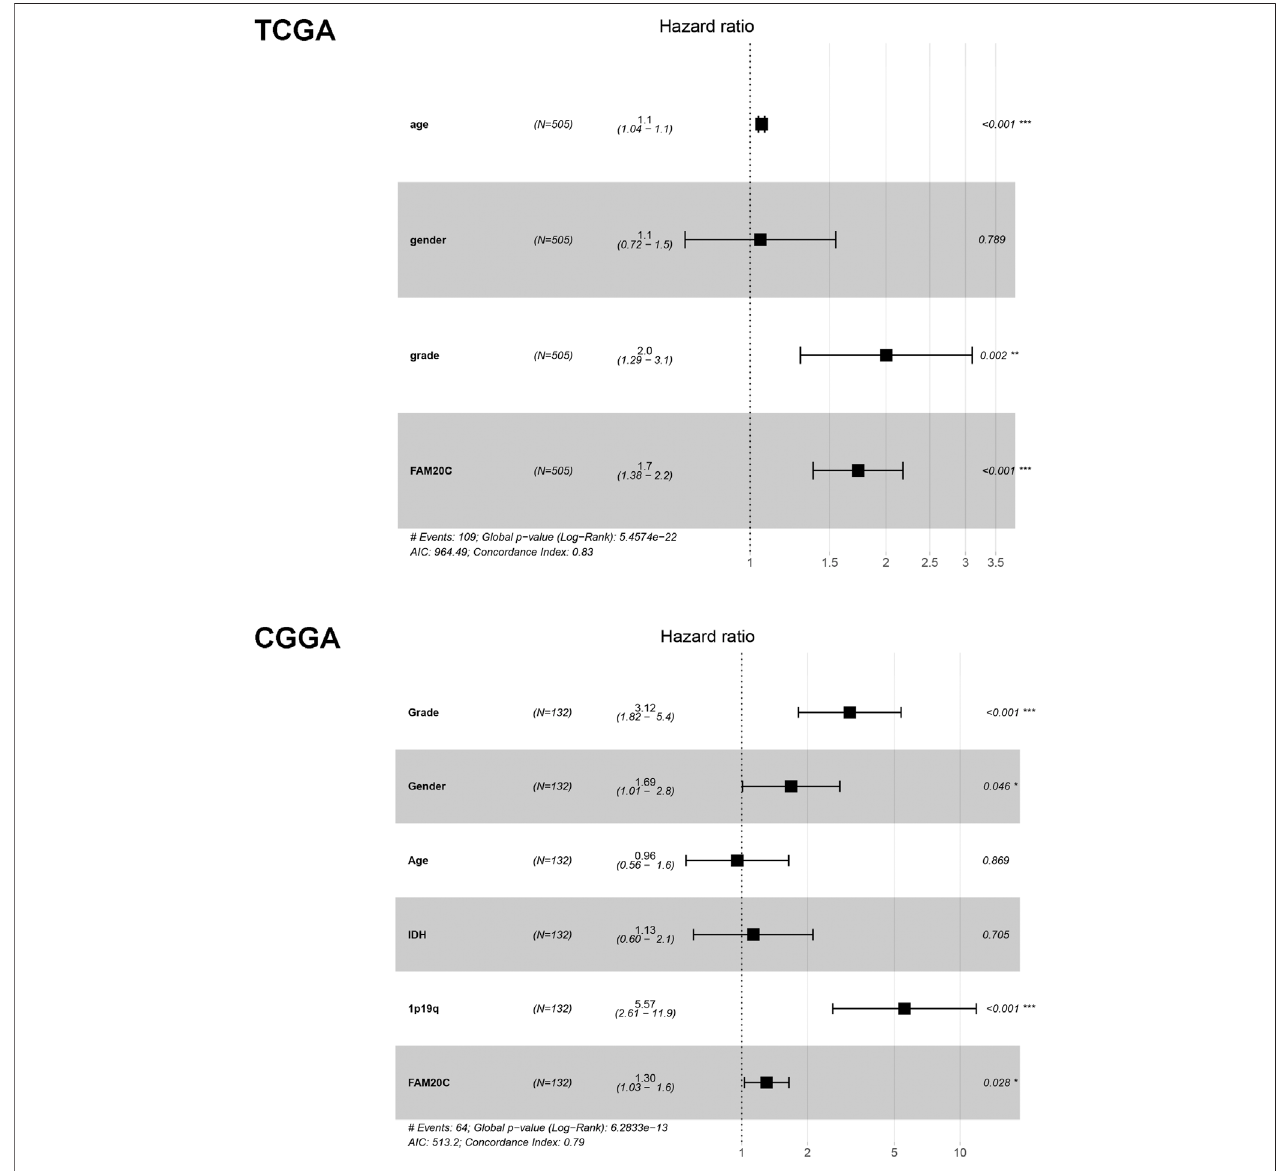
FIGURE 3 | Multivariate Cox analysis evaluating independently predictive ability of Fam20c for OS in TCGA and CGGA database. ** p < 0.01; *** p < 0.001.